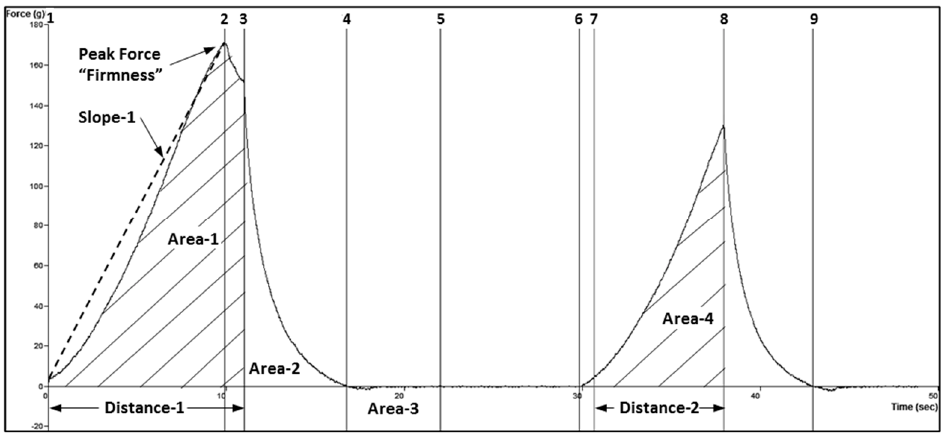
Figure 1. Positions 1 − 8 on fillet used for texture profile analysis. Shaded area was removed from the fillet before cooking [26].